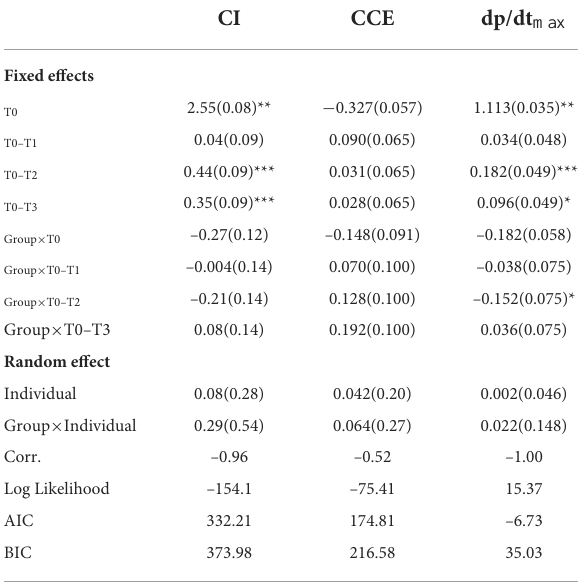
TABLE 2 Linear mixed effects of hemodynamic